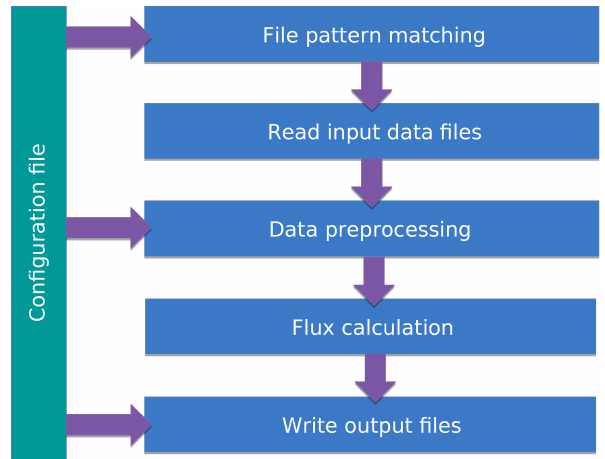
Figure 1. Conceptual diagram showing the way that input data are imported and used by FluxEngine. Single or groups of files are spec- ified using a plain-text configuration file. File names are interpreted using a subset of regular expression matching syntax (Unix glob patterns), and additional tokens are used to substitute time and